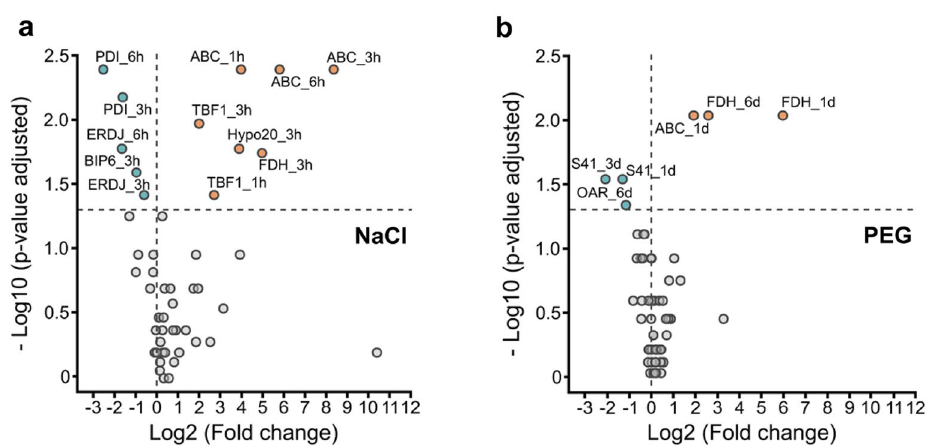
Figure 5. Volcano plot of mRNA level changes of candidate marker genes relative to control, in response to ( a ) 500 mM of NaCl (salt stress), ( b ) 30% (w/v) PEG-induced dehydration. Each dot represents one gene at one time point labelled: Name_Time point. Gene statistically up-regulated were labelled in orange (positive Log2) and in blue even down-regulated (negative Log2). Statistical differences between treated sample and control were determined using Kruskal–Wallis followed by Dunn test and p-values were adjusted with Holm method (* P < 0.05, n =